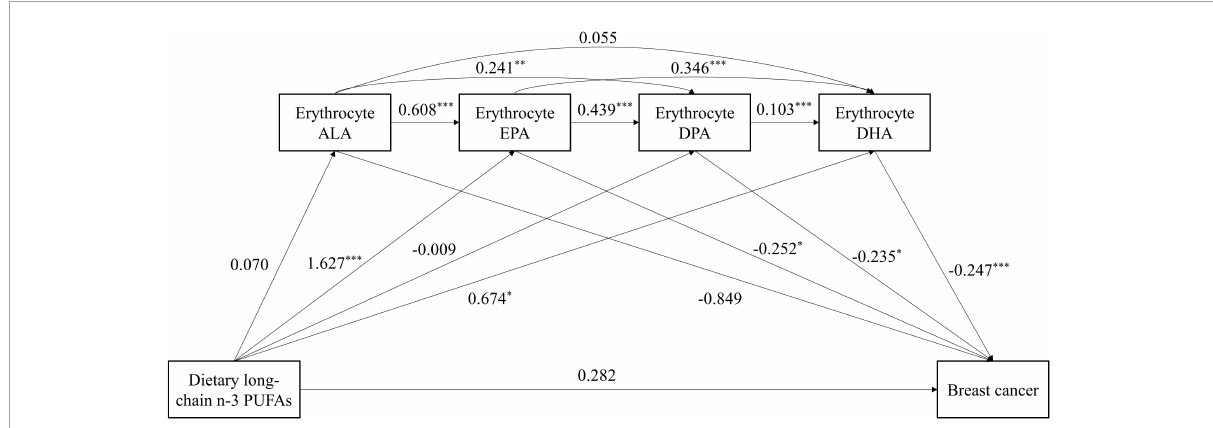
FIGURE2 The chain mediating effect of erythrocyte n – 3 PUFAs on the relationship between dietary long-chain n – 3 PUFA intake and breast cancer risk. ALA, α -linolenic acid; DHA, docosahexaenoic acid; DPA, docosapentaenoic acid; EPA, eicosapentaenoic acid; PUFA, polyunsaturated fatty